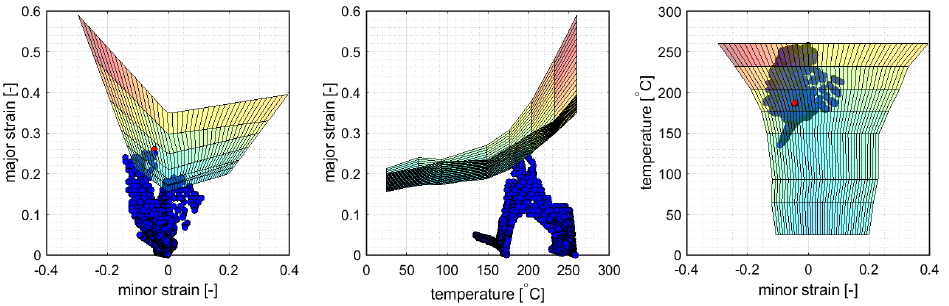
Figure 4. ( Left ): 3D FLC represented as a limiting surface with depicted element loading points at the predicted critical drawing depth; a critical element (red) exceeds the surface. ( Right ): Contour plot of the major strain at the inner surface of the deep-drawn cross-die cup at the predicted onset of necking.